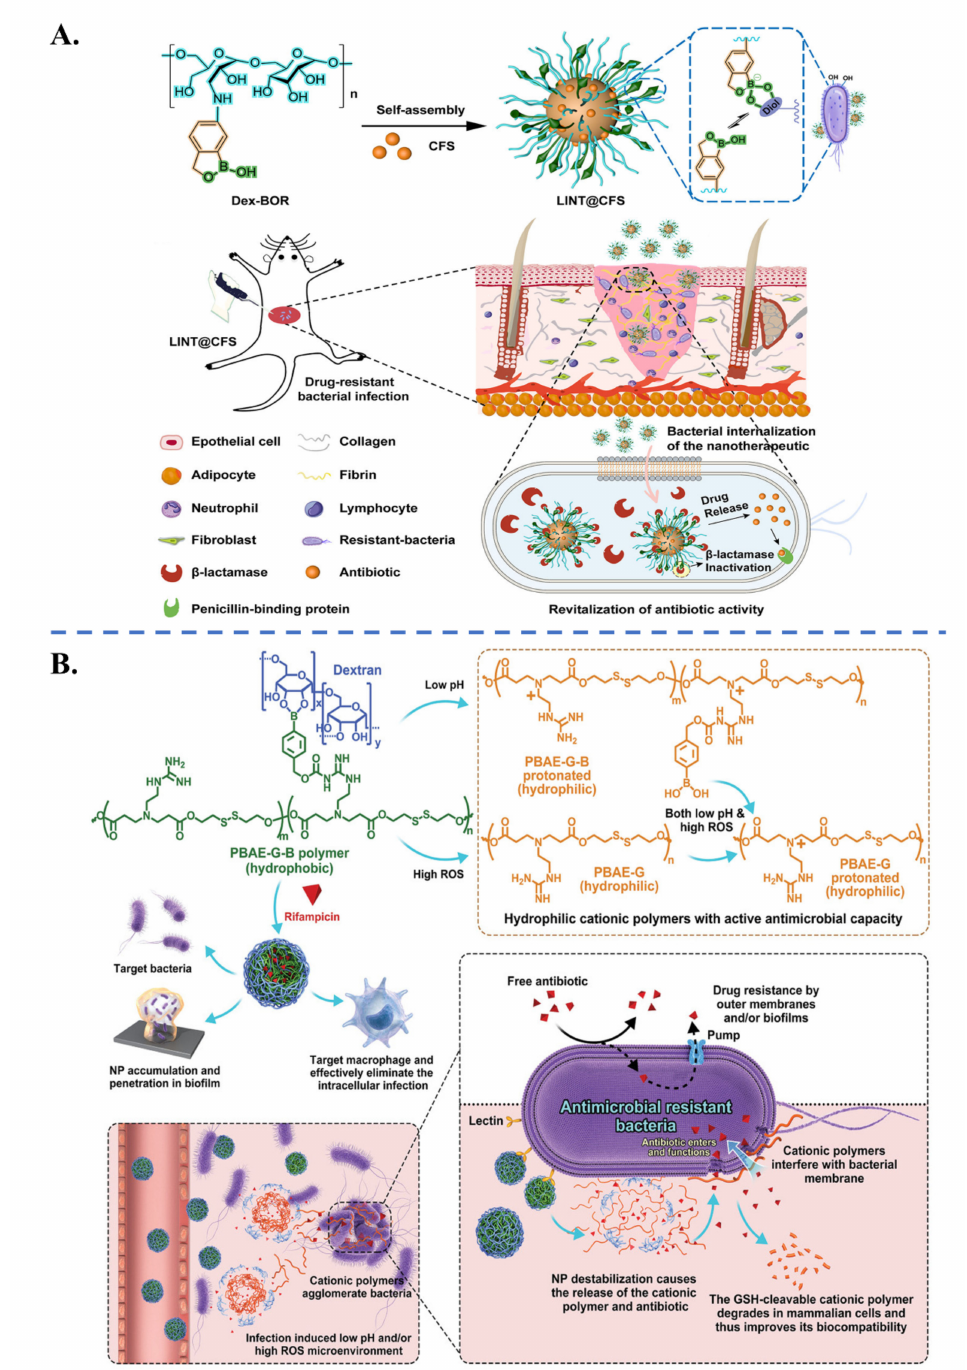
Figure 11. Examples of nanocarrier platforms for co-delivery of antibiotic combination. ( A ) Schematic Illustration of antibiotic-loaded nanocarrier with β -lactamase reversible, competitive inhibitory activity for the treatment of antibiotic-resistant, bacteria-infected wound (reprinted with permission from [135], copyright 2021 ACS). ( B ) Schematic illustration of the composition and the antibacterial mechanism of a multifunctional NP platform for co-delivery of antibiotic combination (Solubility enhancement, passive and active targeting delivery, pH- and ROS-responsive drug release, and co- delivery of dual drugs) (reprinted with permission from [103], copyright 2021 John Wiley and